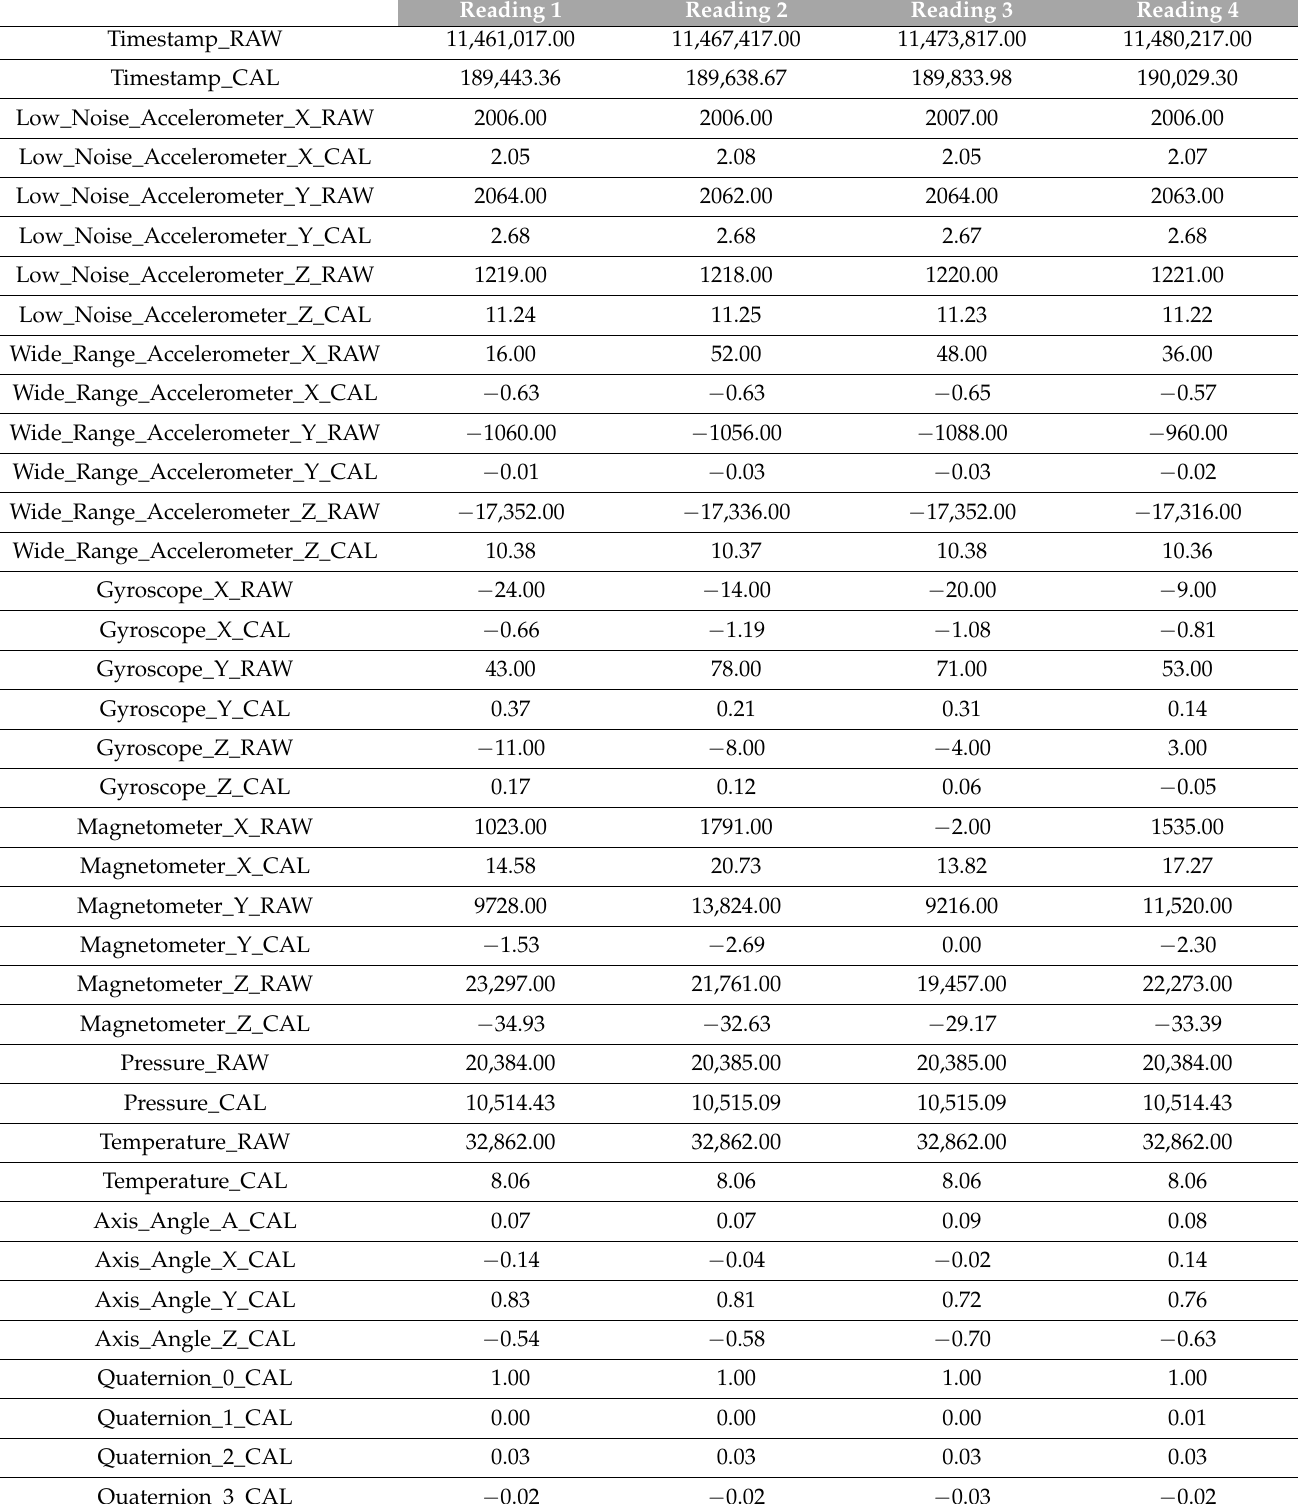
Table 1. Sample reading of data returned from the inertial measurement unit (IMU). Accelerometer values are in metres per second squared (m/s 2 ), the gyroscope returns degrees per second ( ◦ /s) and the magnetometer provides flux (cgs)